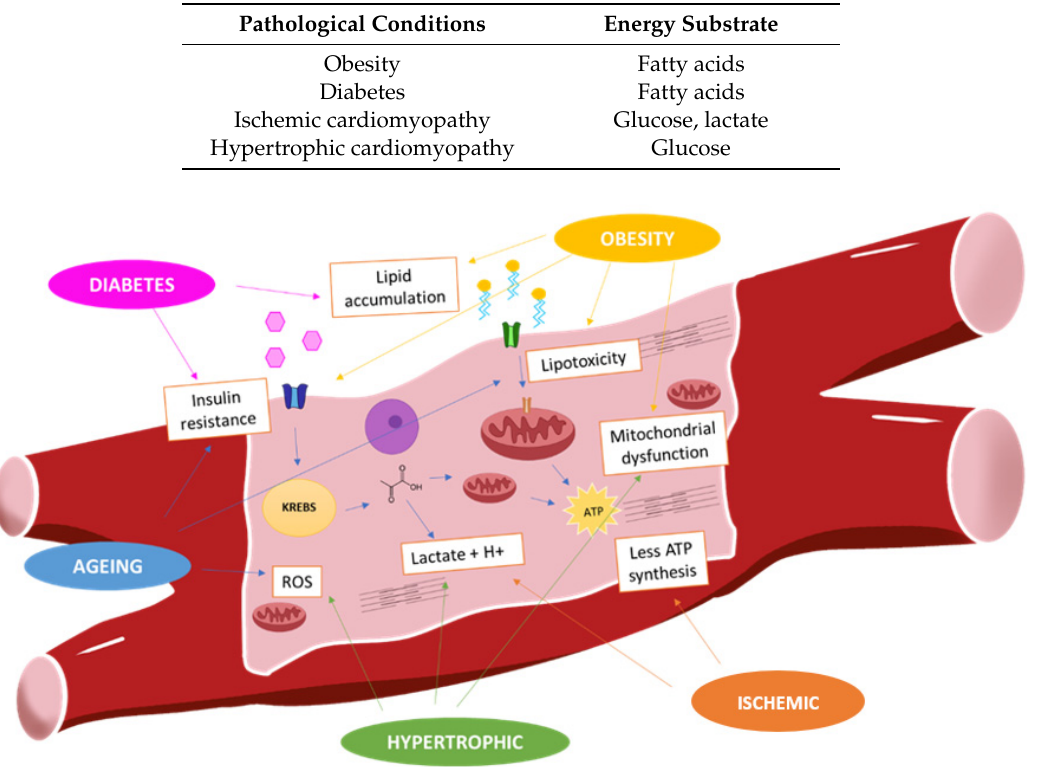
Figure 2. Epicardial fat metabolism in physiological and pathological situations: The figure represents an adipocyte (yellow) and a blood vessel. Glucose is the main fuel of energy in adipocytes to be used